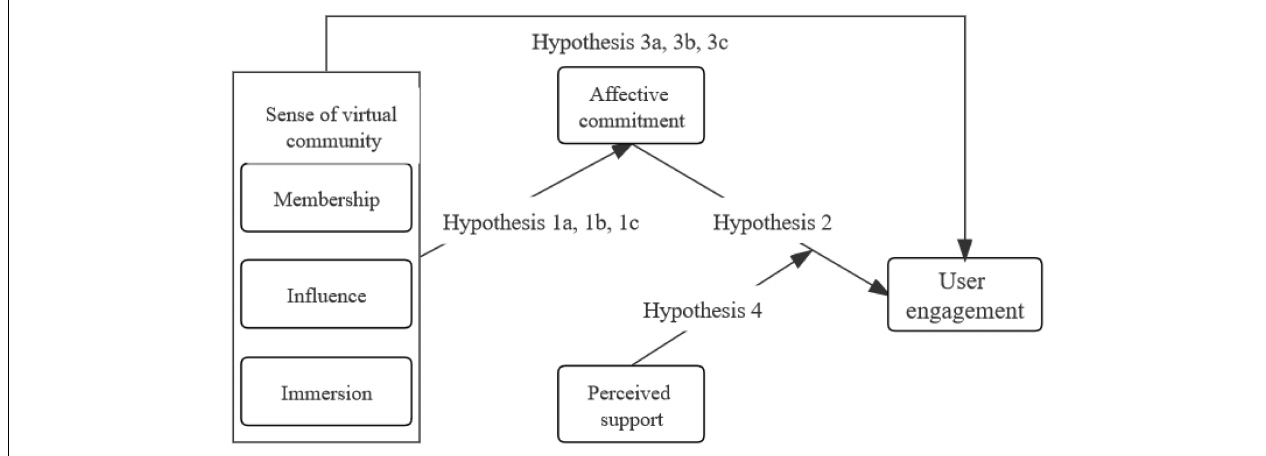
FIGURE 1 | Theoretical